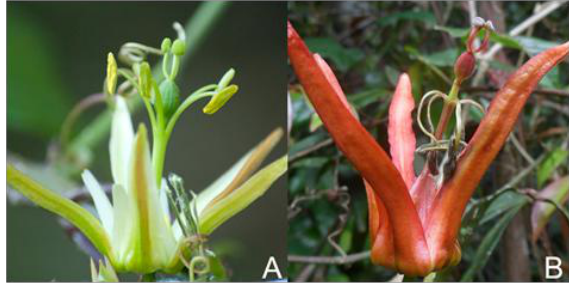
F IGURE 2. Short style morph in Passiflora herbertiana. (A) Young flower with short, erect styles that lack normal movement patterns. Note anther dehiscence. (B) Older flower with short styles that remain in original position and anthers that have released all available pollen (photo credit: R. Van